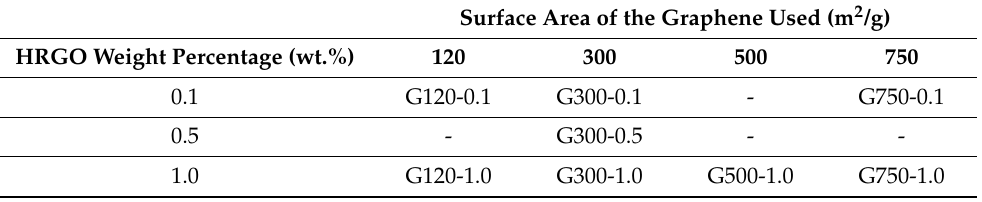
Table 3. Nomenclature of bone cement composition with HRGO manufactured in the form of 100 × 100 × 5 mm 3